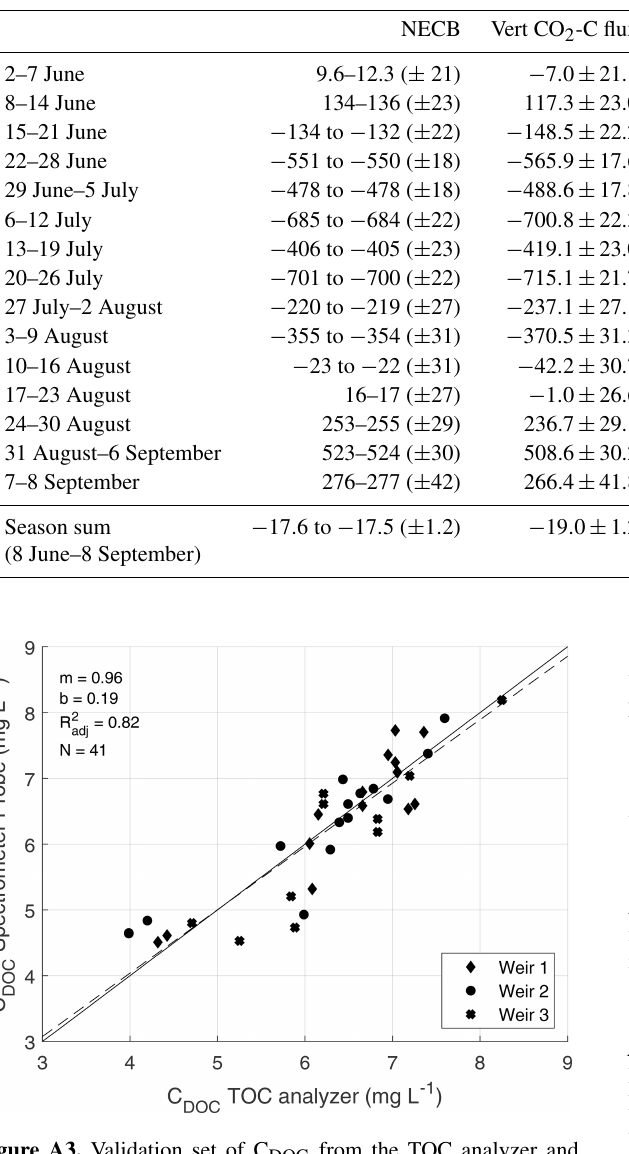
Data availability. The dataset of this study is published at PAN- GAEA (https://doi.org/10.1594/PANGAEA.944186) (Beckebanze et al.,